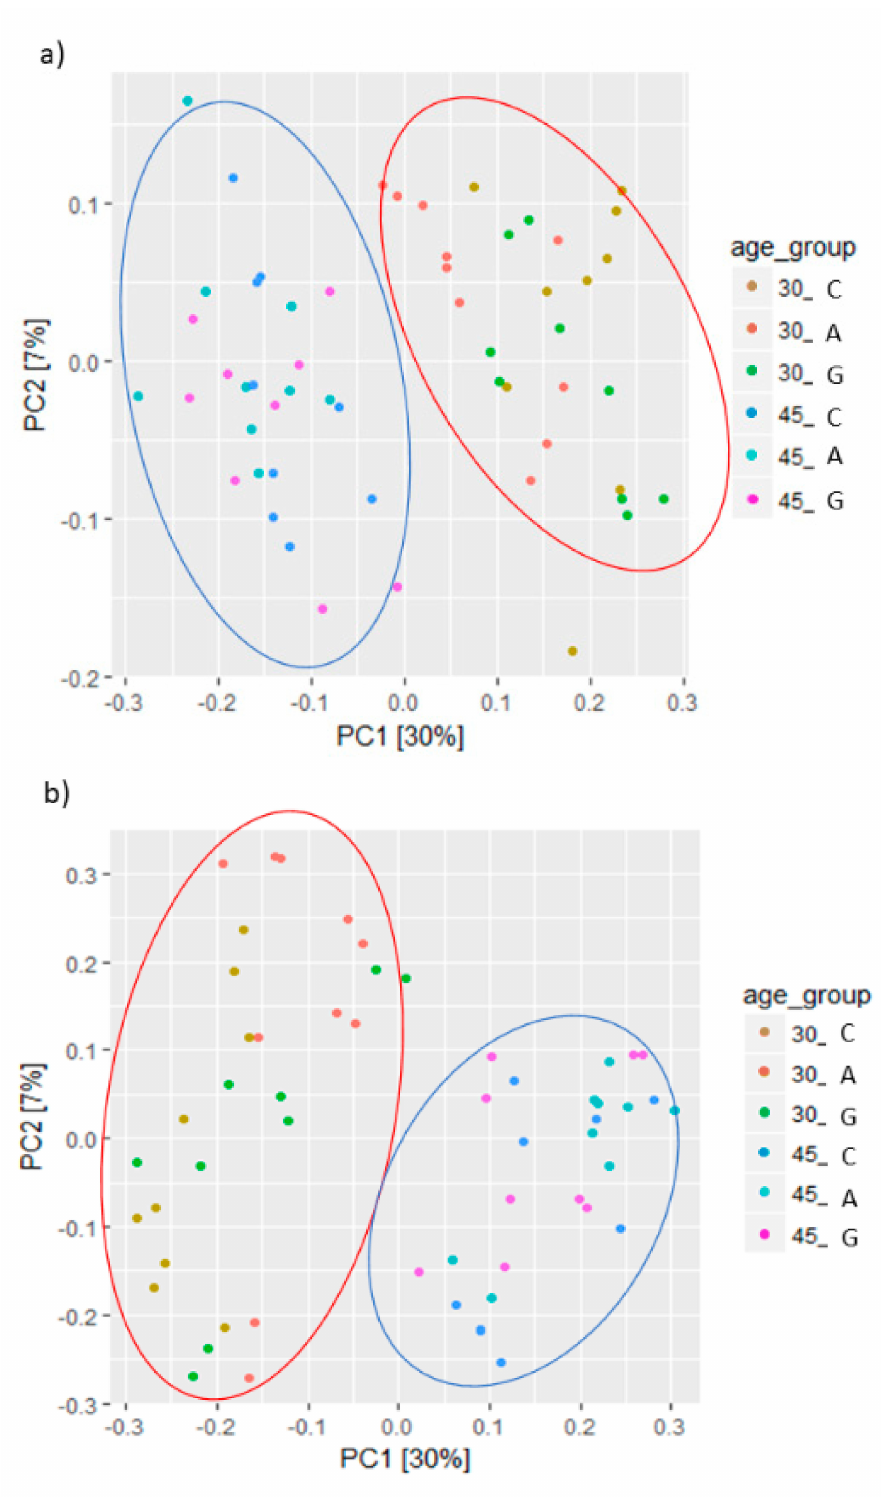
Figure A2. MDS plots of the rarefy weighted UniFrac distances ( a ) and Bray–Curtis distances ( b ) of caecal microbiota of rabbit fed a dietary supplementation of dehydrated alfalfa or fresh grass in peri-weaning period (those at 30 and 45 days of age were analyzed). Principal component (PC)1 and PC2 values for each sample are plotted; the percentage variation explained by each PC is shown in brackets. C = rabbit fed pelleted feed only; A = rabbit fed pelleted feed + dehydrated alfalfa; G = rabbit fed pelleted feed + fresh